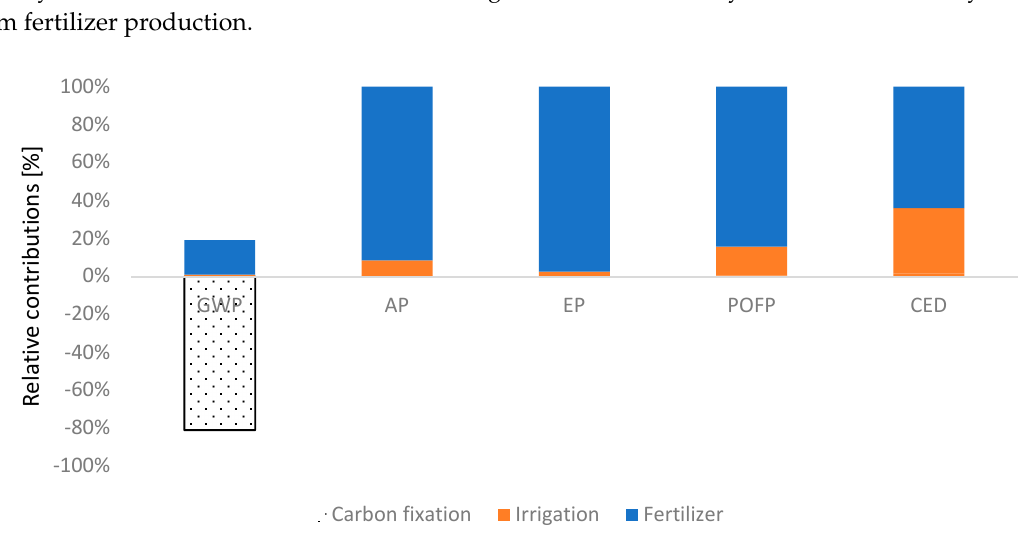
Figure 5. Breakdown of contributions from process involved in Subsystem 1.